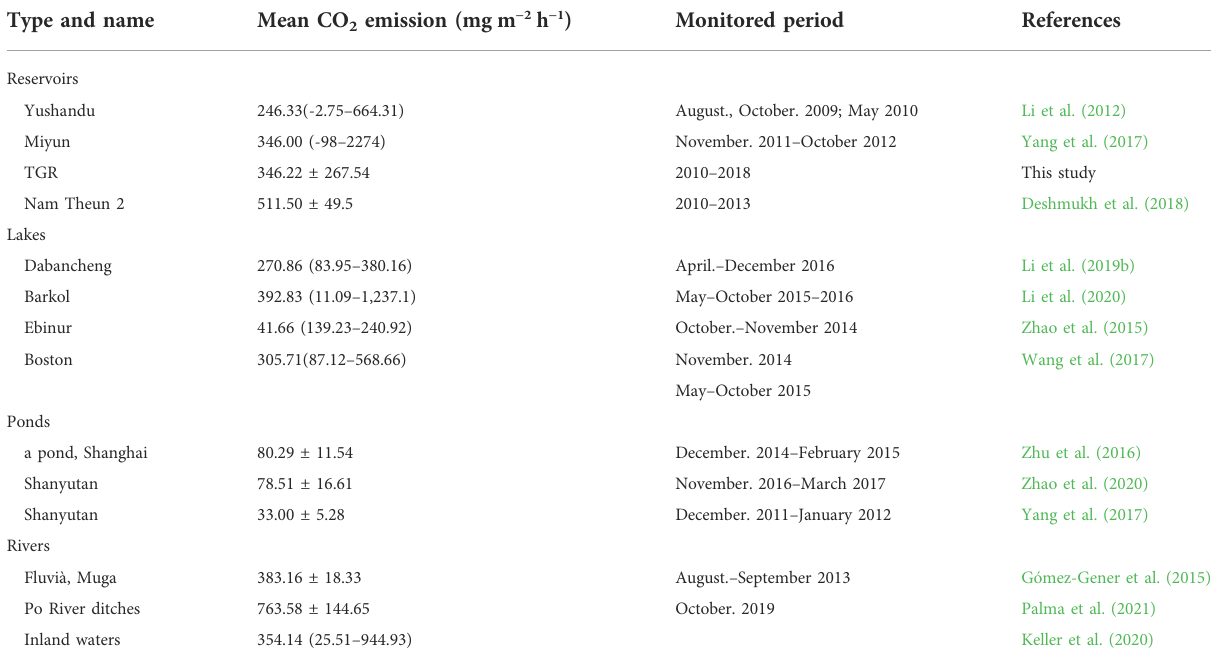
TABLE 3 Comparison of CO 2 fl ux among the different types of inland waters in the drained